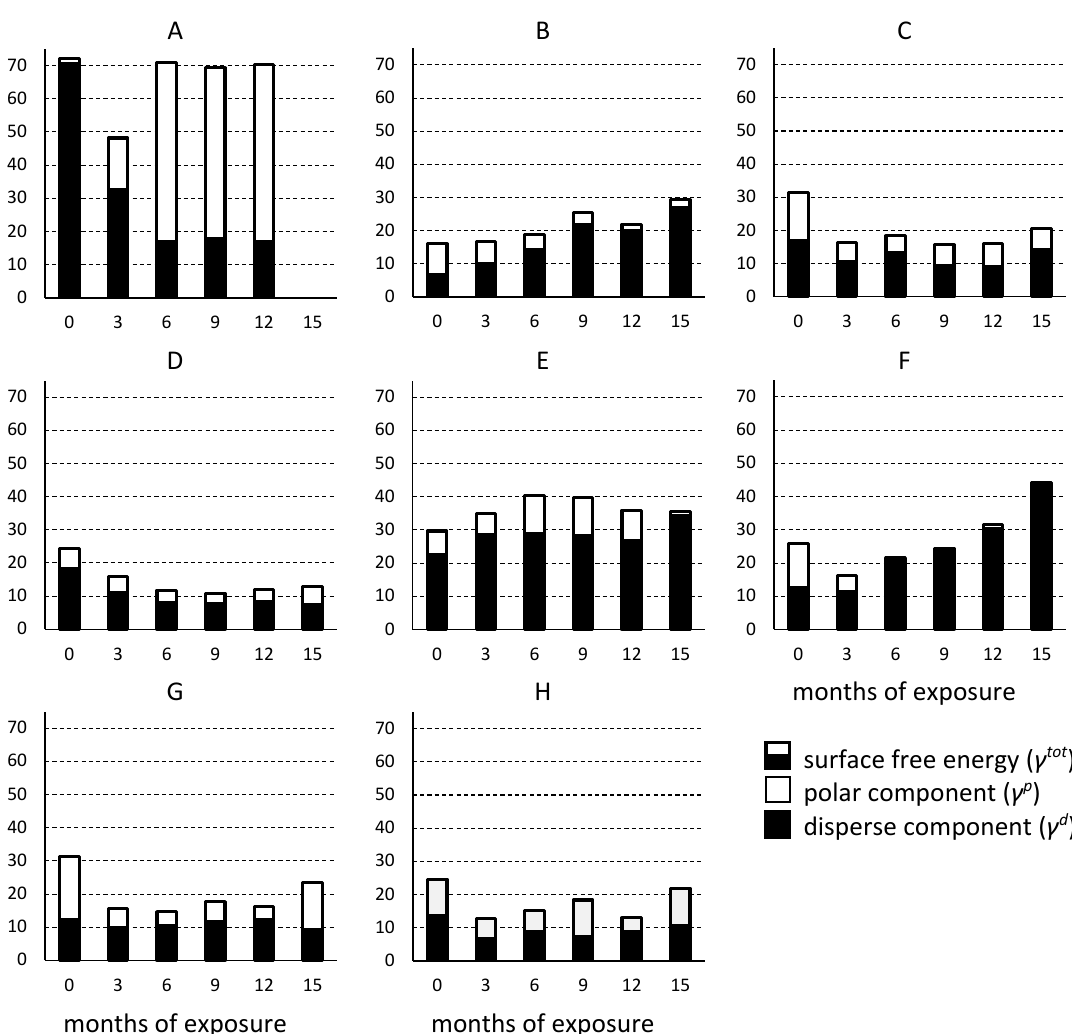
Figure 6. Surface free energy ( γ tot ) including polar ( γ p ) and disperse ( γ d ) components. A–H: sample